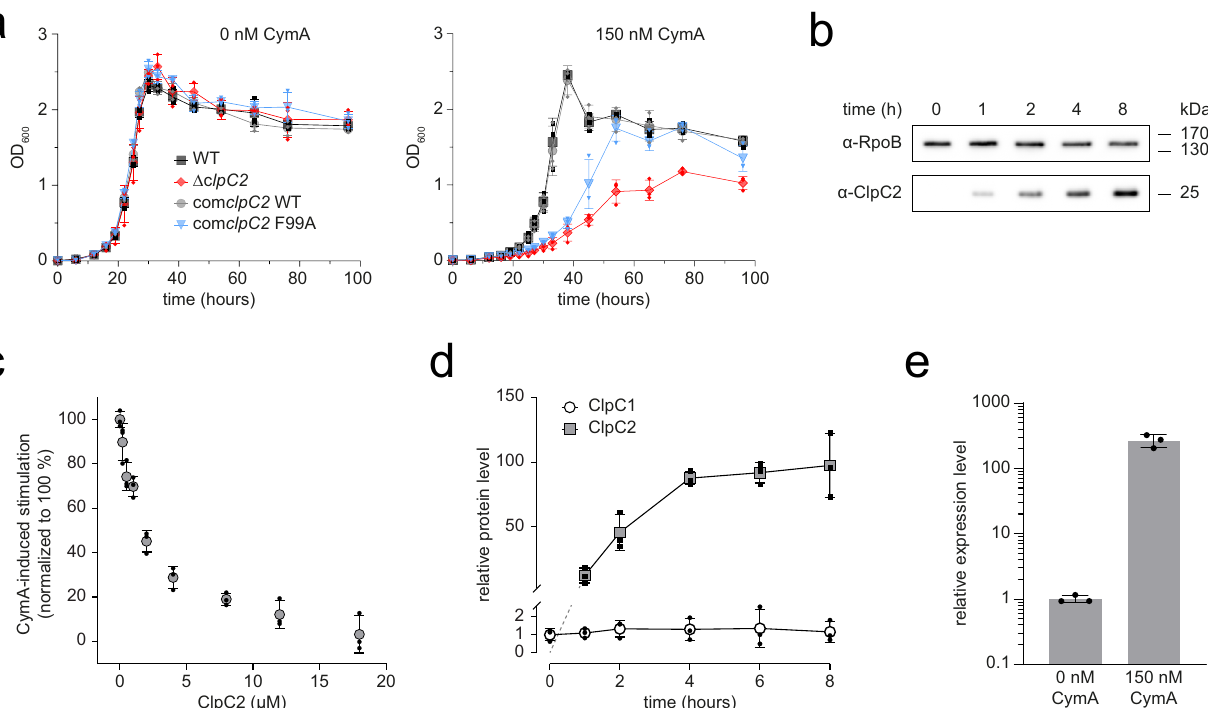
Fig. 3 ClpC2 protects Msm against CymA toxicity. a A clpC2 knockout ( Δ clpC2 ) strain was prepared in Msm. The Δ clpC2 (red diamonds), parent (WT, black squares) as well as Δ clpC2 strains complemented with clpC2 WT (com clpC2 WT, grey circles) or complemented with clpC2 F99A (com clpC2 F99A, blue triangles) were grown to exponential phase, then diluted to an OD 600 of 0.005 before monitoring the OD 600 of the cultures grown in either the absence or presence of 150 nM CymA. Error bars depict the standard deviation from three biological replicates. b The effect of CymA on cellular ClpC2 protein levels was analysed by Western blot. Msm culture was grown to an OD 600 of 0.5 in 7H9 medium at 37 °C before adding 150 nM CymA. Cells were harvested, then lysed at the indicated time points following addition of CymA. RpoB is included as a loading control. c The counteractive effect of ClpC2 in a CymA-stimulated FITC-casein degradation assay. The proteolytic activity of 0.5 µ M ClpC1 hexamer/0.8 µ M ClpP1P2 tetradecamer was stimulated by 2 µ M CymA and the rate of degradation was determined following the addition of increasing concentrations of ClpC2. The rate of degradation is normalised so that 0% stimulation is the proteolytic activity in the absence of CymA and 100% stimulation is equivalent to the maximum CymA-induced stimulation above basal activity. Error bars represent standard deviation from three independent experiments. d Quantitative Western blot was employed to analyse the ratio of ClpC1 (open circles) to ClpC2 ( fi lled squares) following addition of CymA. Msm culture was grown to an OD 600 of 0.5 in 7H9 medium at 37 °C before adding 150 nM CymA. Samples were harvested at the indicated time points following addition of CymA and ClpC1 or ClpC2 proteins quanti fi ed by immunoblotting in reference to a protein standard curve using puri fi ed ClpC1 and ClpC2 protein. ClpC1 and ClpC2 protein levels are normalised relative to ClpC1 at timepoint 0 h. Representative blots are shown in Supplementary Fig. 3. Error bars depict standard deviation from biological triplicates. e Expression levels of clpC2 in the absence and presence of 150 nM CymA as analysed by RT-qPCR. Msm cultures were grown to an OD 600 of 0.5 followed by a one-hour incubation in either the absence or presence of 150 nM CymA. clpC2 gene expression was normalised to the housekeeping gene rpoB . Error bars represent standard deviation of technical triplicates from three biological replicates. Statistical analysis by two-tailed unpaired Student ’ s t test; P value =